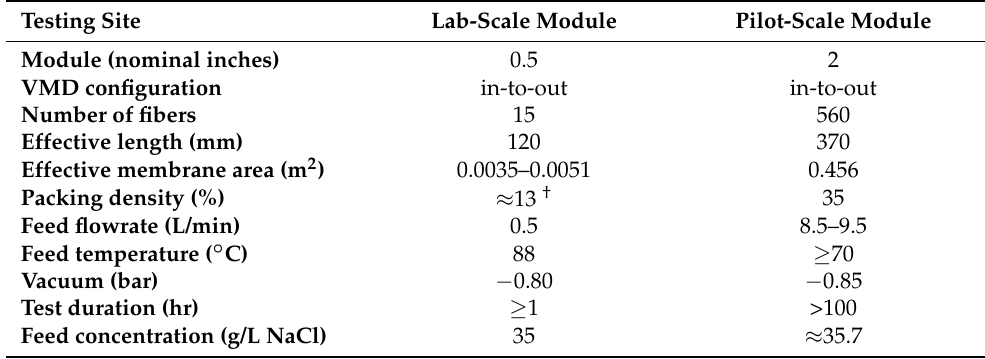
Figure 2. Process flow schematic for the vacuum membrane distillation (VMD) used for testing 2- inch modules at START.